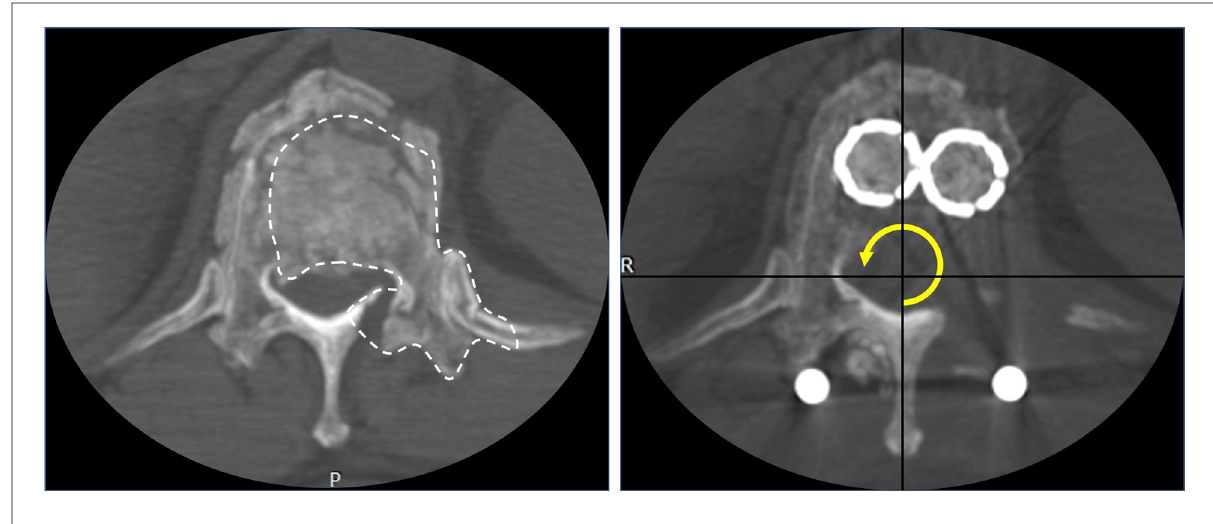
FIGURE 5 Transverse images of pre-operation and after 270° canal decompression. The white dotted line represents the range of decompression and the yellow arrow represents the decompressed area in